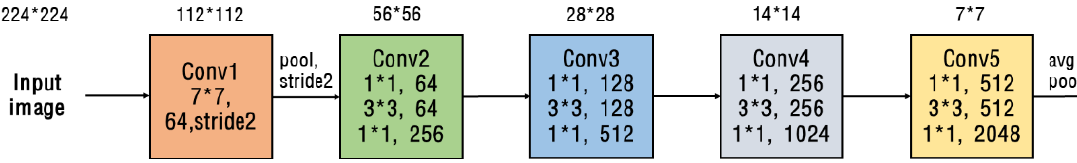
Figure 13. Structure of ResNet-101.